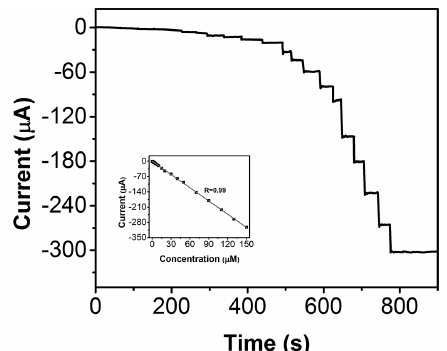
FIGURE 5 - Amperometric response of the B-ZnO/GCE with successive addition of H \ plot of Ipa versus H